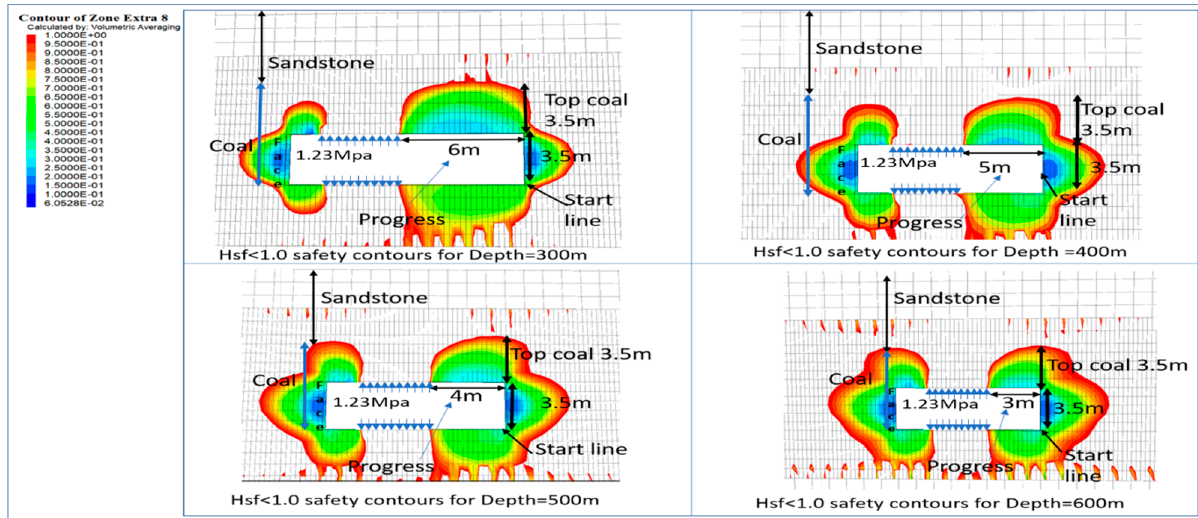
Figure 4. Modeling for different depth values.